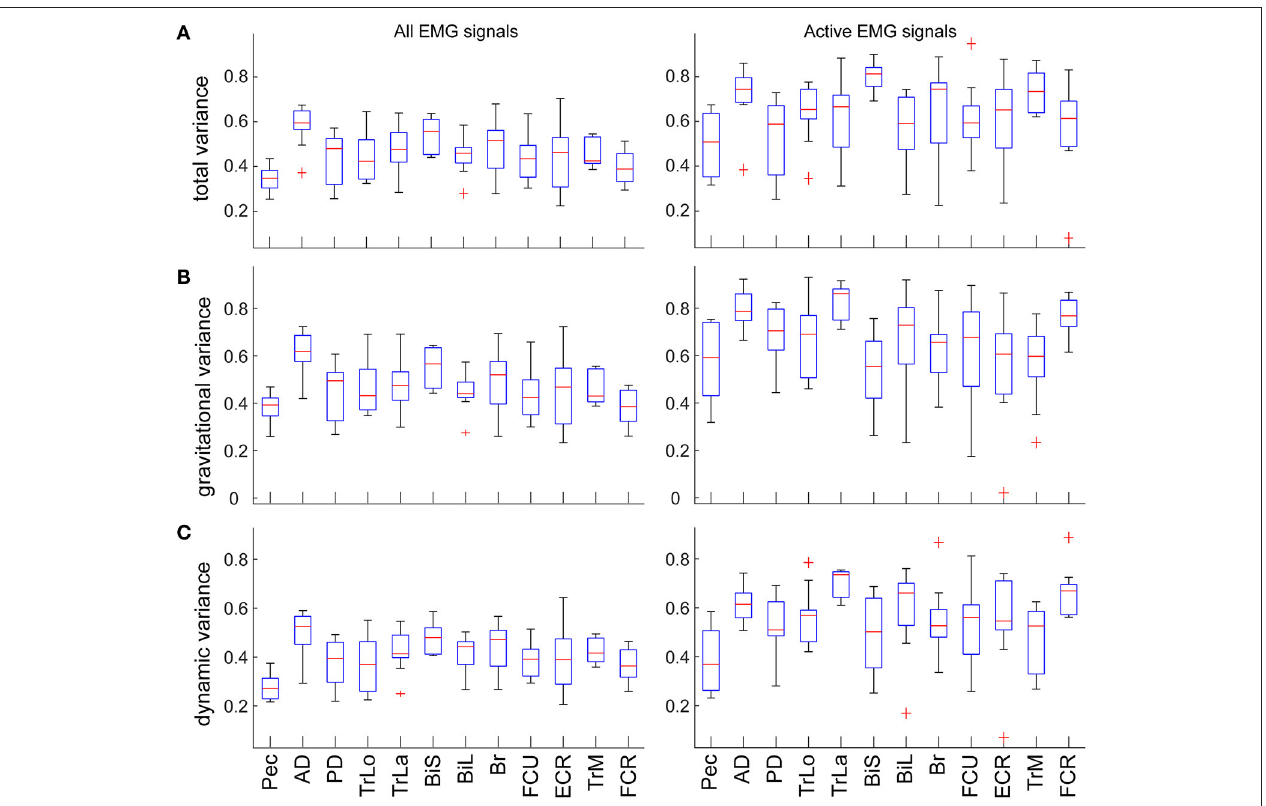
FIGURE 4 | Variance accounted for by the individual components in EMG per muscle. Values are means across subjects and signals; boxes indicate ranges of 25 and 75 percentiles in data; error bars show standard deviations; red crosses indicate outliers. Plots in the left column show values across all EMG signals; plots in the right column show values from a subset of EMG signals that were active > 30% of maximal per movement per subject. (A) Total variance accounted for by torque decomposition of EMG per muscle. (B) Relative variance accounted for by the gravitational principal component. (C) Relative variance accounted for by the dynamic principal